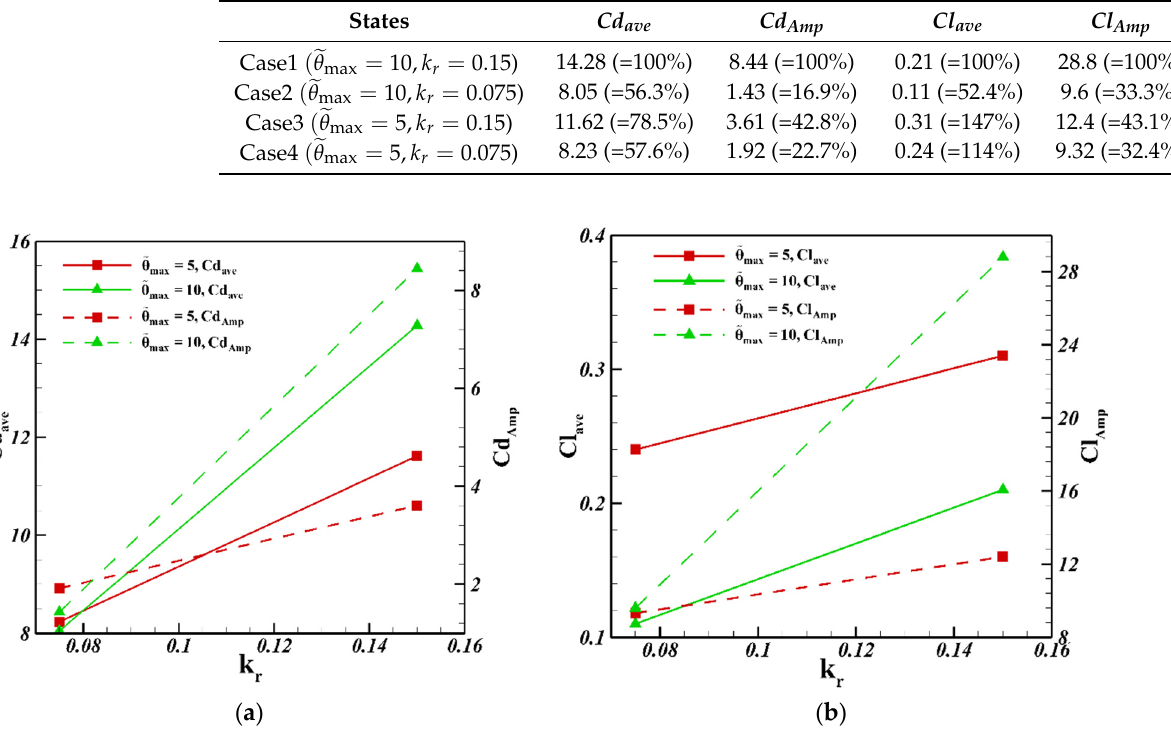
Figure 10. The variation curve of the lift-drag coefficient with the oscillation frequency under the same oscillation amplitude. ( a ) drag coefficient. ( b ) lift coefficient.